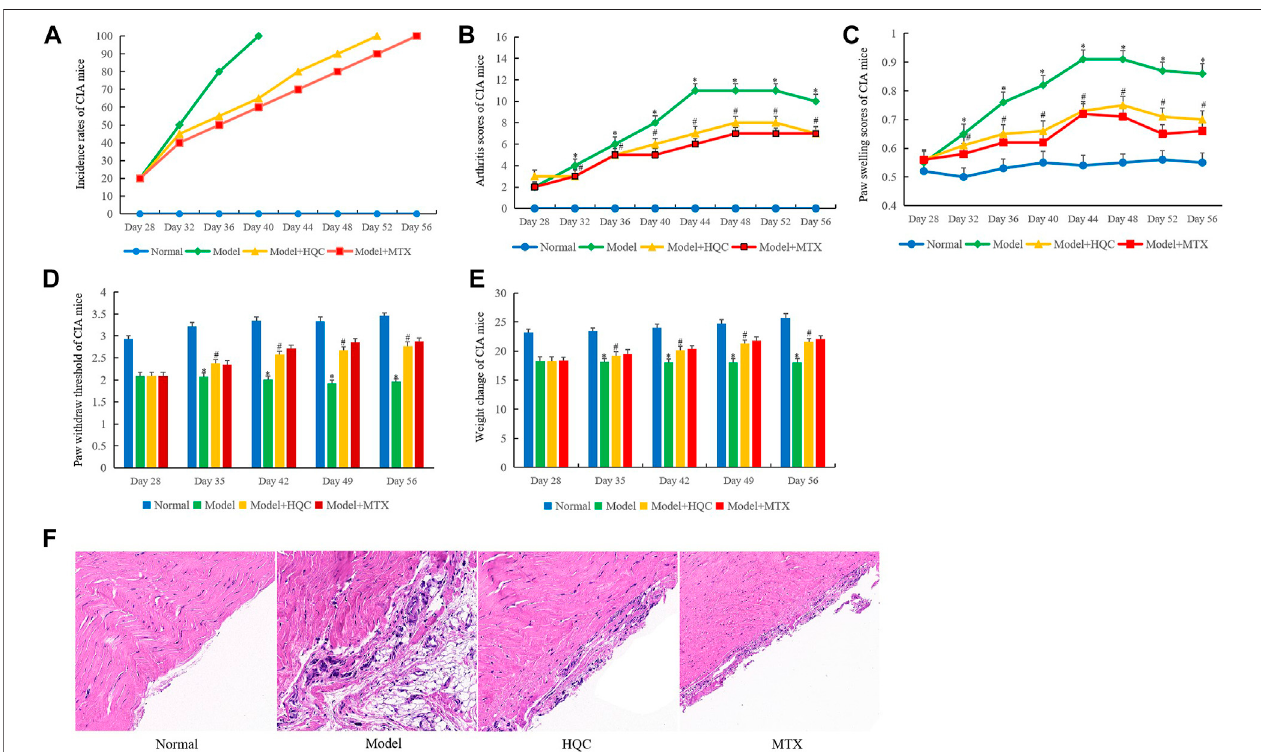
FIGURE 1 | HQCameliorates the severity of arthritis of CIA mice. The effects of HQC on CIA mice were evaluated, including the incidence rate, arthritis score, paw swellingscore,pain sensitivity and body weight. (A) ,theeffects ofHQC on theincidence ratesofCIA mice were evaluated; (B) ,arthritis scoreofmice ineach group; (C) , paw swelling score in each group; (D) : the pain sensitivity of each group was characterized by paw withdraw threshold; (E) : the health status of each group was evaluated by the weight change of mice; (F) : the effects of HQC on synovial pathology of model mice was evaluated by HE staining, “ Normal ” is normal group, “ Model ” is model group, “ HQC ” is HQC treatment group, “ MTX ” is positive drug MTX group. *Model group was compared with normal group; # HQC group was compared with model